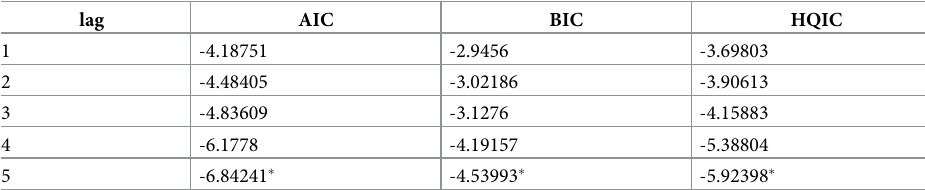
Table 14. Lag test of PVAR model for logistics industry and manufacturing